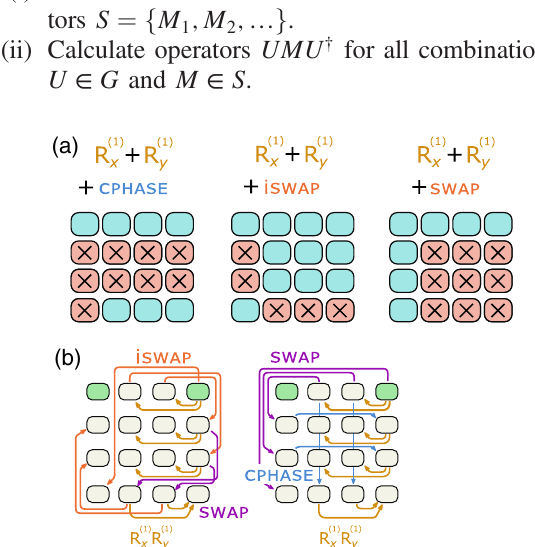
FIG. 6. (a) Illustration of the unreachable measurement oper- ators (crossed out in red) when the gate set consists of single- qubit gates on the control qubit together with one two-qubit gate from the set {c PHASE , i SWAP , SWAP }. (b) Similarly to the combination of c PHASE +i SWAP , combinations SWAP +i SWAP and SWAP +c PHASE also allow full two-qubit